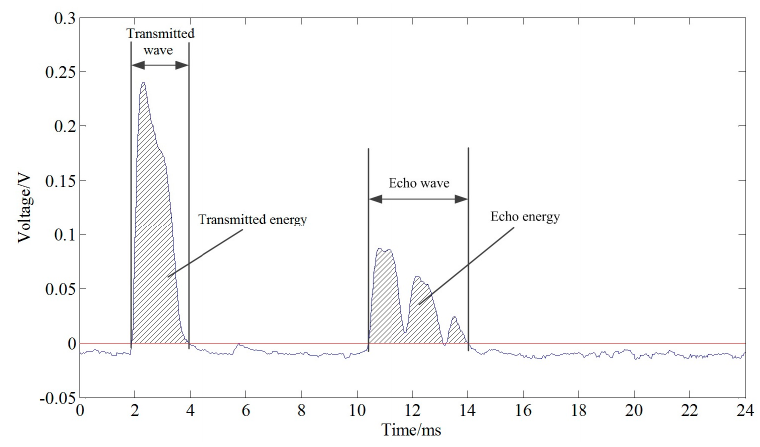
Figure 1. Ultrasonic transmitted wave and echo wave.